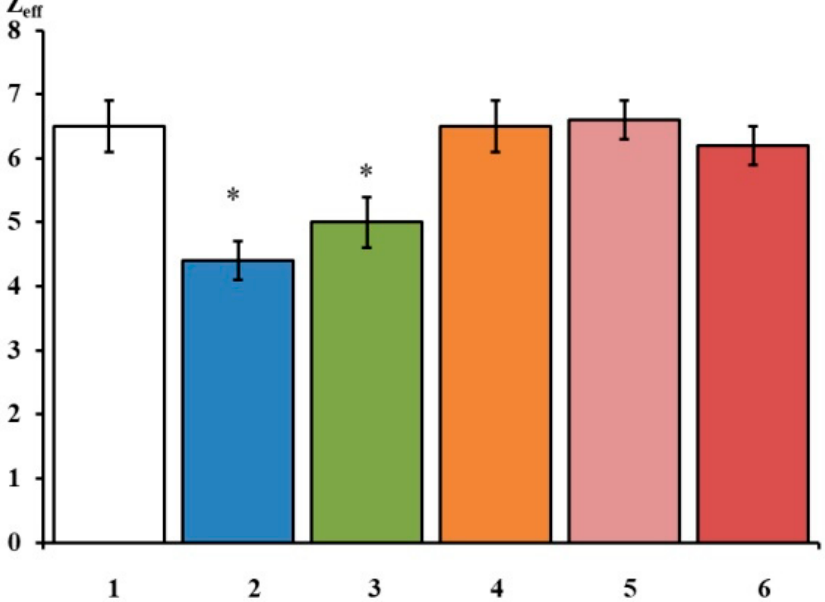
Figure 3. The values of effective charge of the Na V 1.8 channel activation gating system in control conditions (1) Zeff = 6.5 ± 0.4 (n = 20) and after the application of 100 nM peptides: (2) Ac-PRERRA-NH 2 Zeff = 4.4 ± 0.3, (3) Ac-PRARRA-NH 2 Z eff = 5.0 ± 0.4, (4) Ac-RAR-NH 2 Z eff = 6.5 ± 0.3, (5) Ac-RAAR-NH 2 Z eff = 6.6 ± 0.3, (6) Ac-REAAR-NH 2 Z eff = 6.2 ± 0.3. Data are presented as mean ± SEM. Statistically significant differences between the control and experimental values are designated with asterisks ( p < 0.05) (n = 16–20).